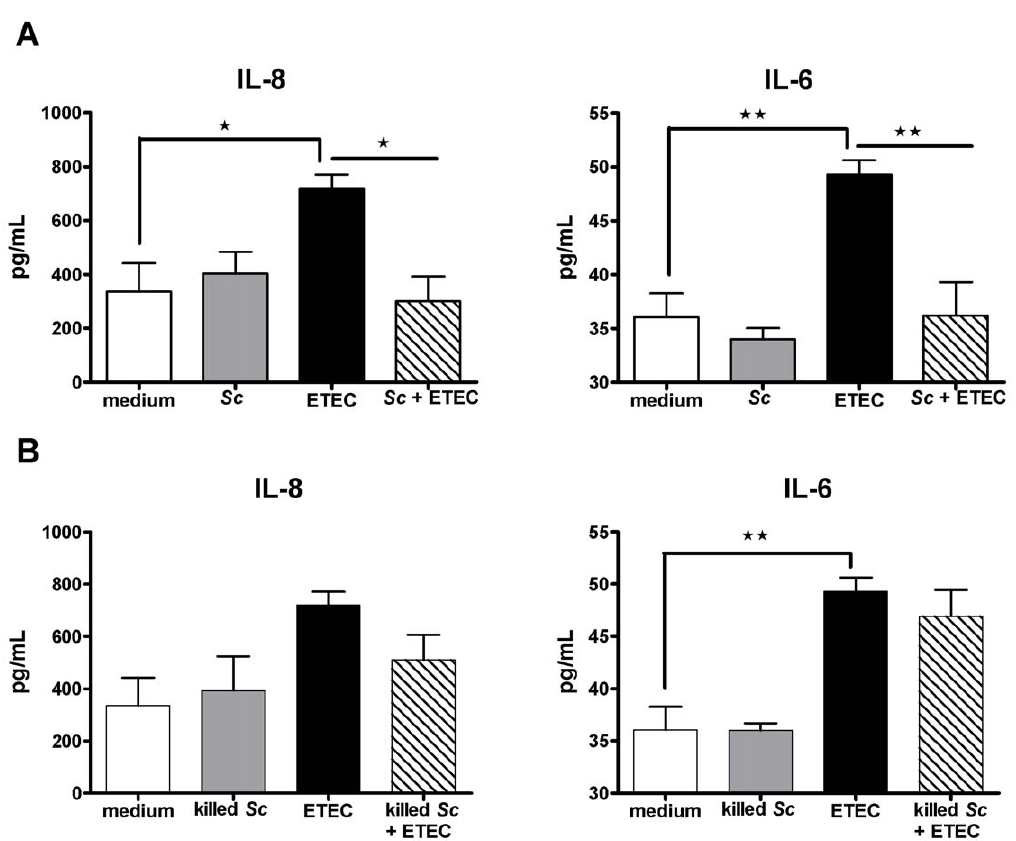
Figure 4. Saccharomycescerevisiae decreases IL-6 and IL-8 secretions induced by ETEC. Differentiated IPEC-1 cells were cultured overnight with (A) viable or (B) killed Sc (3 6 10 6 yeasts/well) and then ETEC (3 6 10 7 CFU/well) was added to the co-culture for 30 min. Differentiated IPEC-1 cells were then washed and cultured for another 24 h before the assessment of apical IL-6 and IL-8 secretions by ELISA. Data are presented as means of cytokine concentration 6 SEM ( n =3-4), asterisks denote: * ( P , 0.05 ), ** ( P , 0.01 ). Data are representative of two independent experiments.